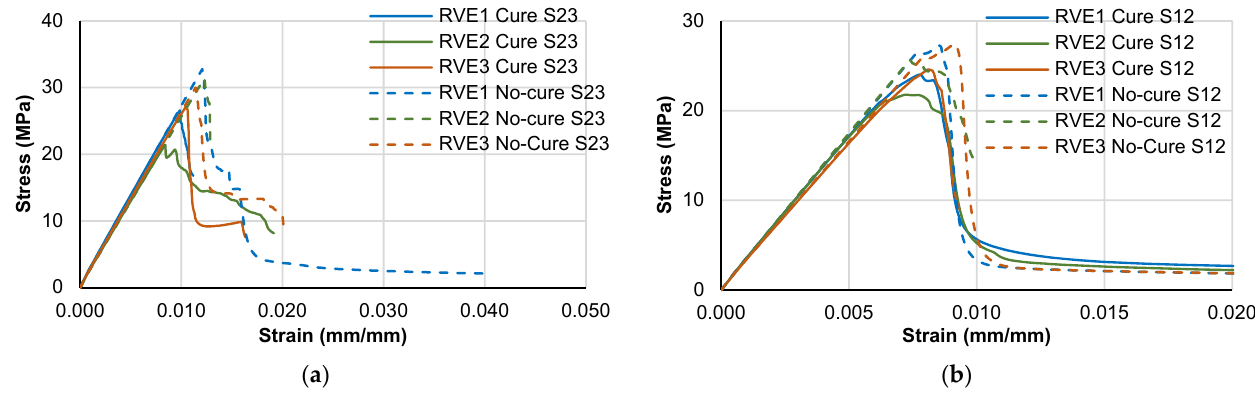
Figure 14. Shear stress-strain response comparison. ( a ) Transverse direction and ( b ) Longitudinal direction.